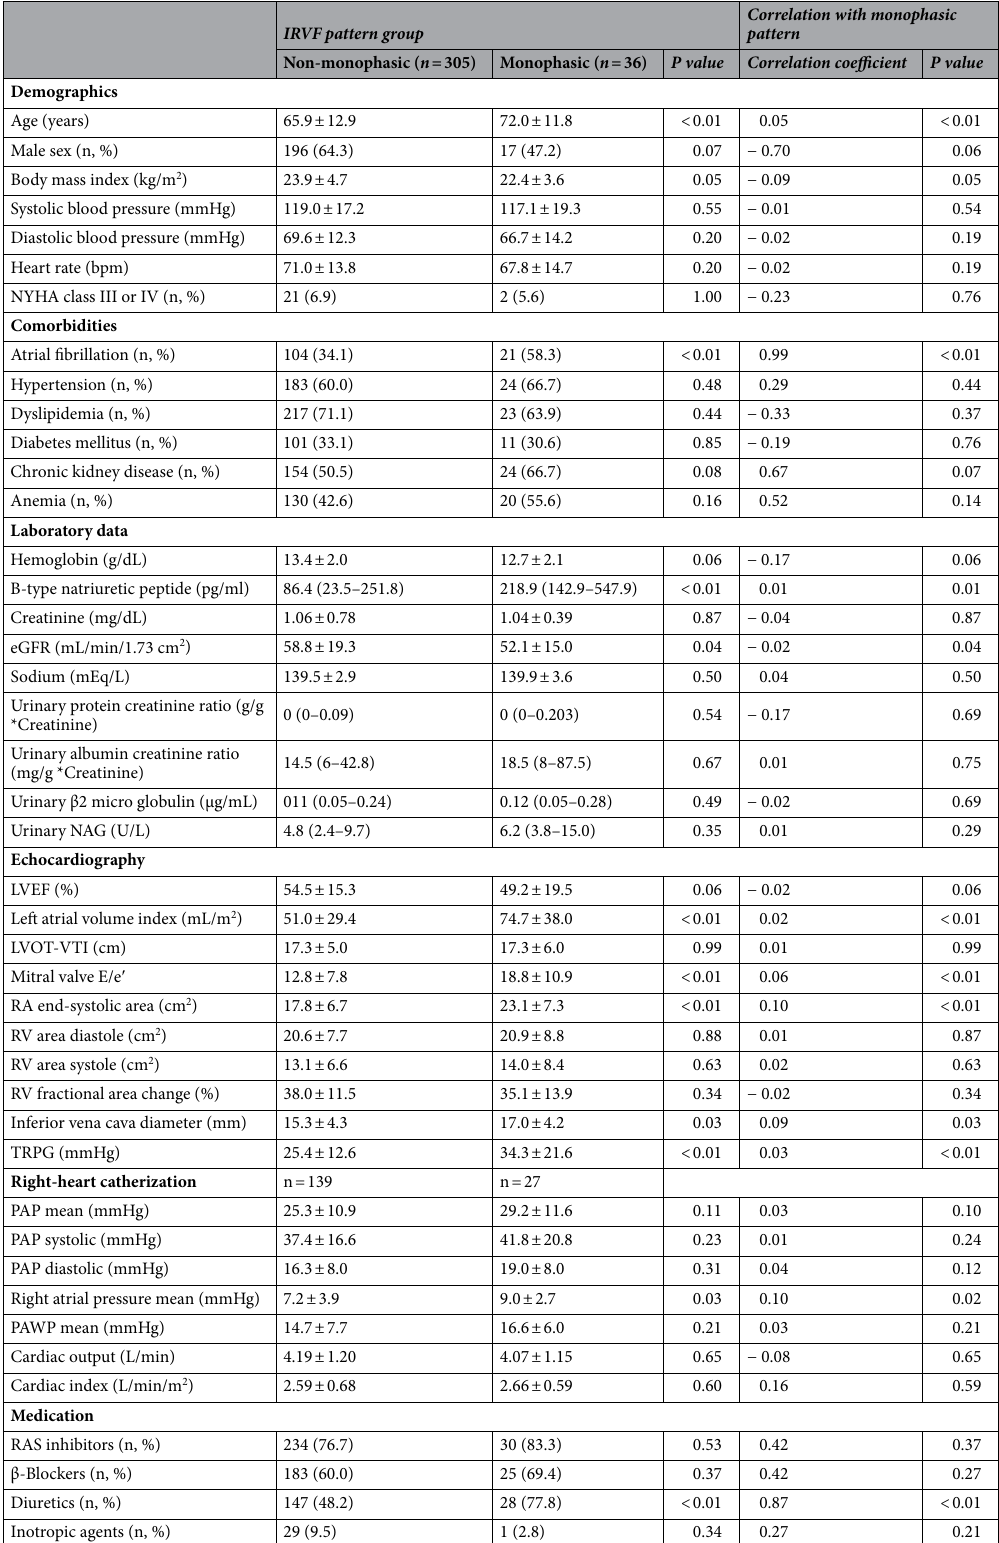
Table 2. Comparisons of patient characteristics among IRVF patterns. IRVF intrarenal venous flow, NYHA New York Heart Association, Egfr estimated glomerular filtration rate, NAG N -acetyl-β-d-glucosaminidase, LVEF left ventricular (LV) ejection fraction, LVOT LV outflow tract, VTI velocity time integral, RA right atrial, RV right ventricular, TRPG tricuspid regurgitation pressure gradient, PAP pulmonary artery pressure, PAWP pulmonary artery wedge pressure, RAS renin-angiotensin